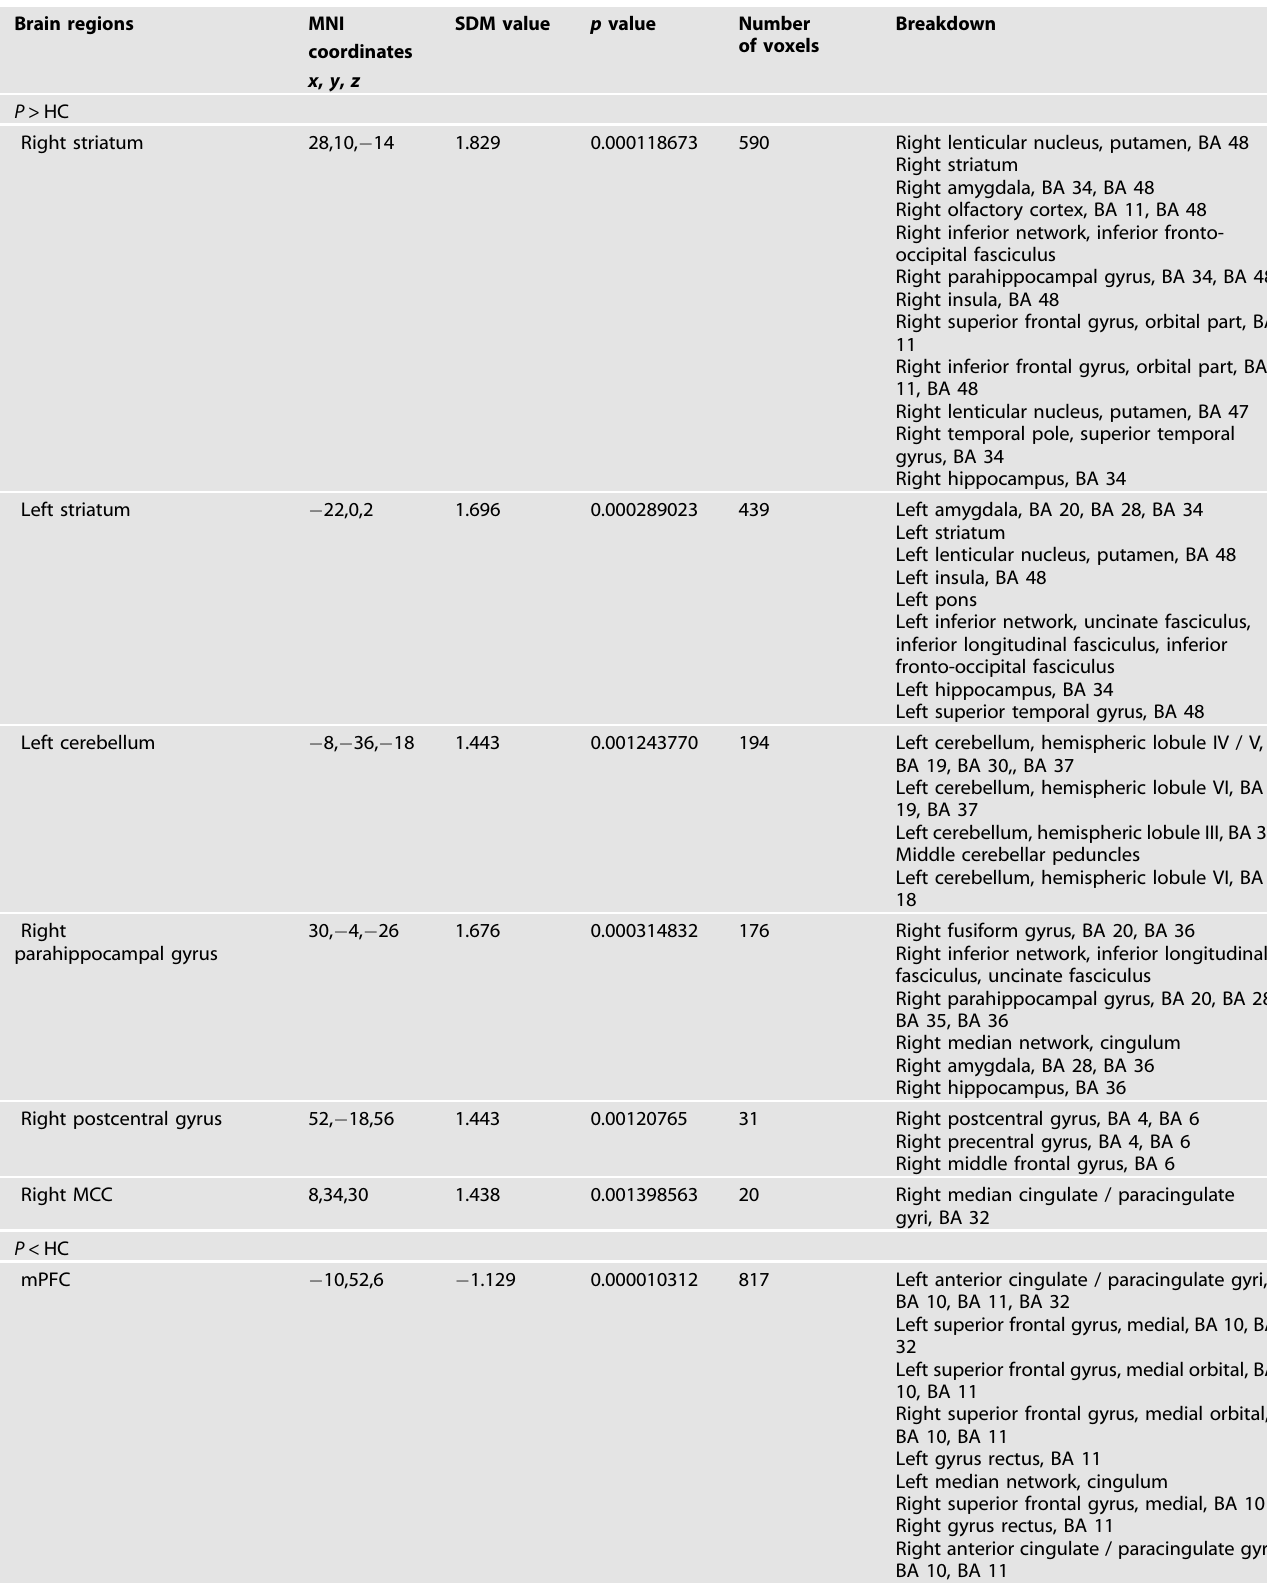
Table 3. Results of the meta-analysis for brain activation difference between SZ and HC during reward outcome